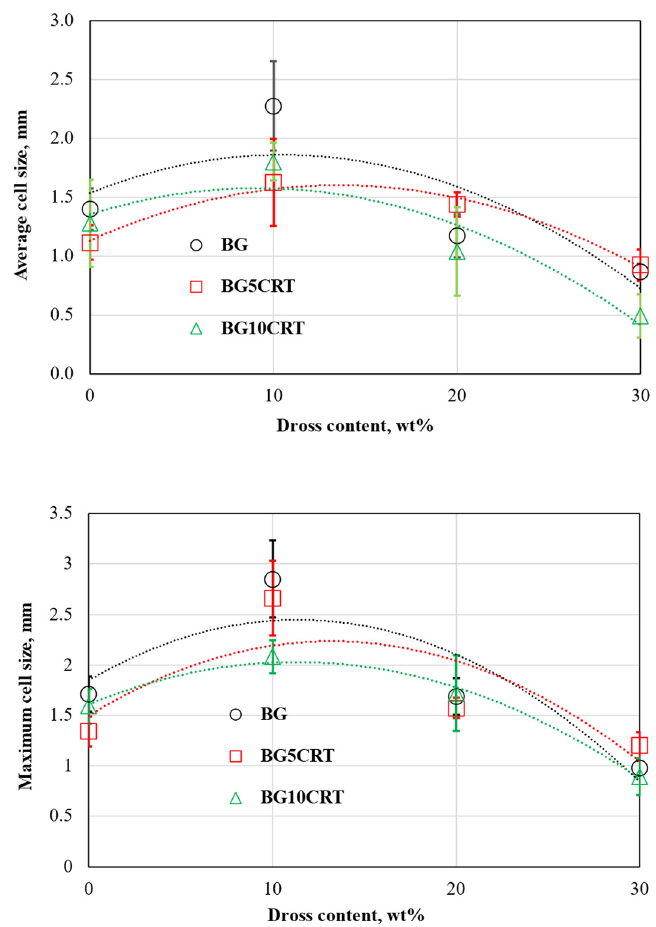
Figure 6. Average and maximum cell sizes of the foam glasses.